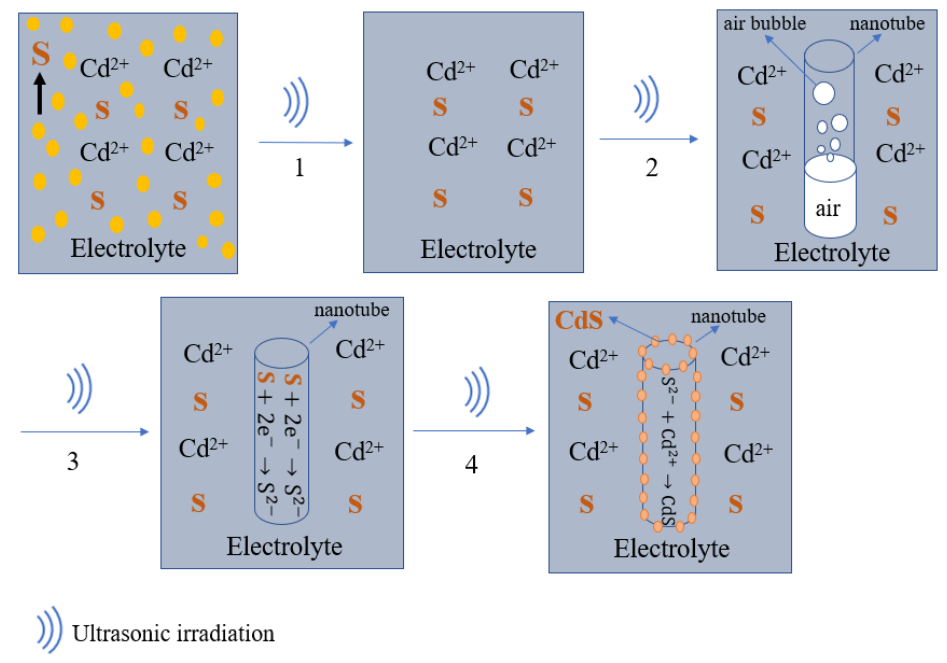
Figure 14. A schematic diagram of the possible sonoelectrochemical deposition interaction; representation modified from